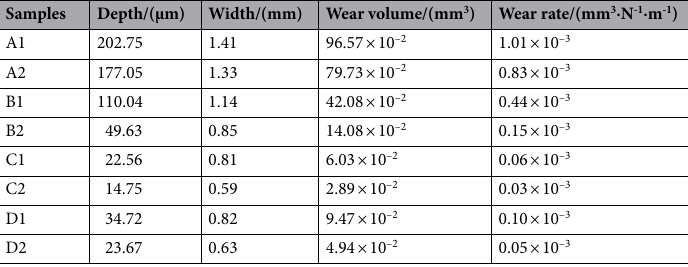
Table 3. Parameters of the wear